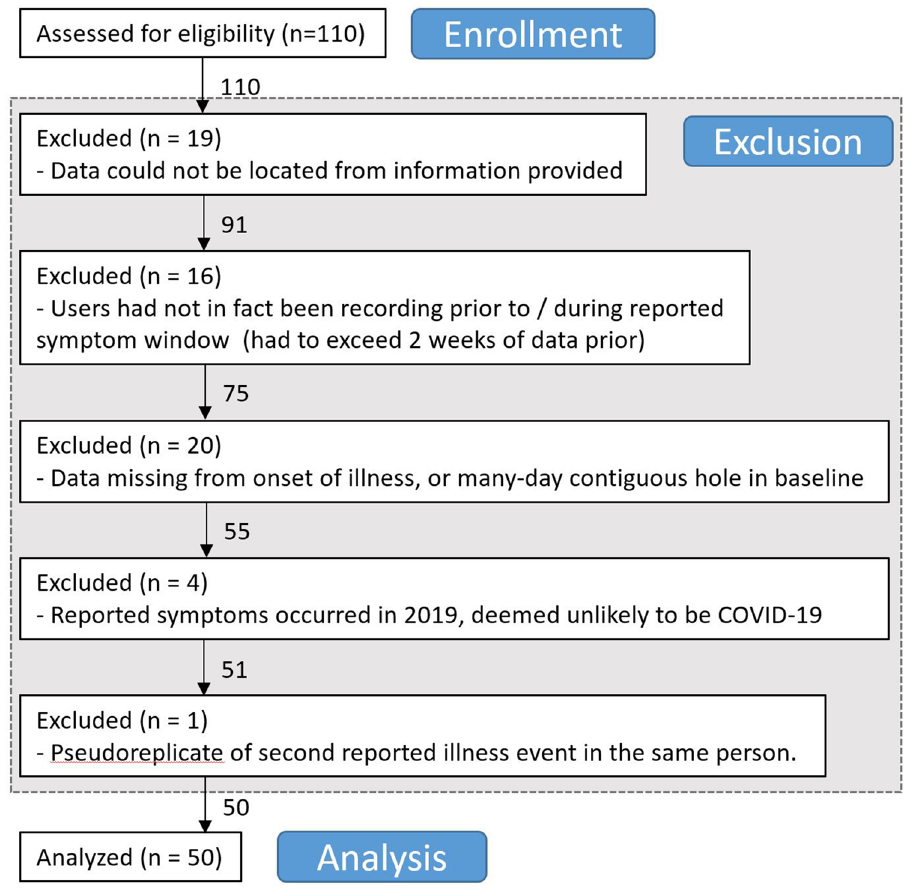
Figure 4. CONSORT (consolidated standards of reporting trials) format flow chart for exclusion of cases from analyses. Although neither this effort nor TemPredict are clinical trials, we show exclusion of participants from the larger dataset for ease of